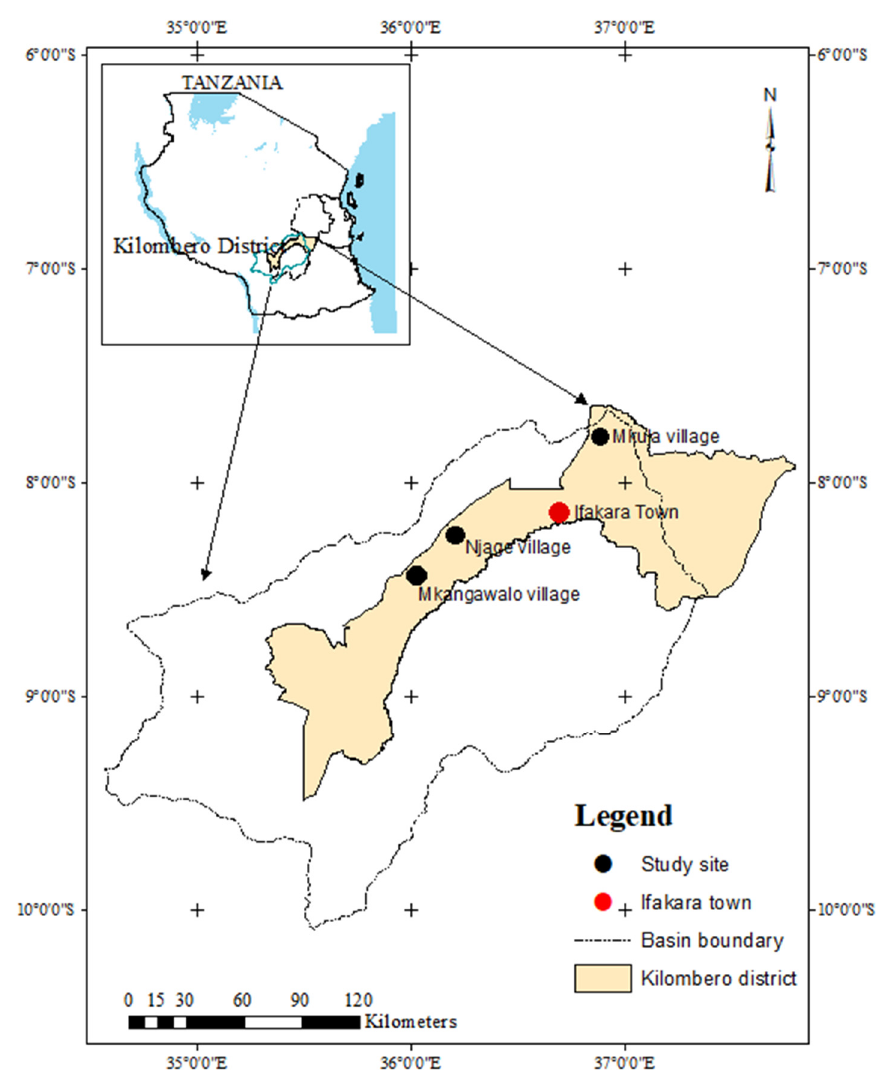
Figure 1. Map of Kilombero District and basin (Tanzania—inset) showing sampling villages in black circles.